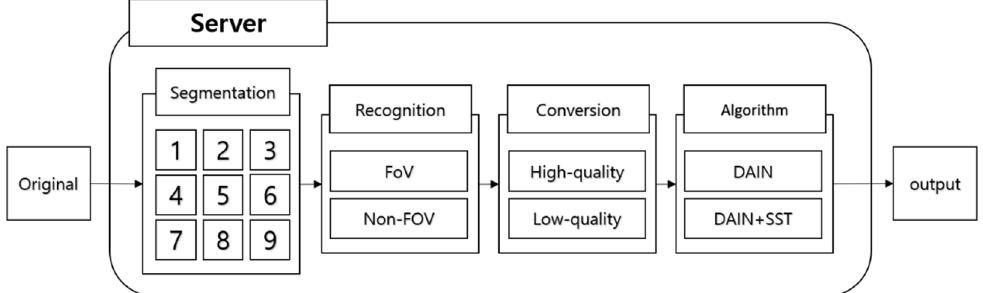
Figure 17. Simulation Process.